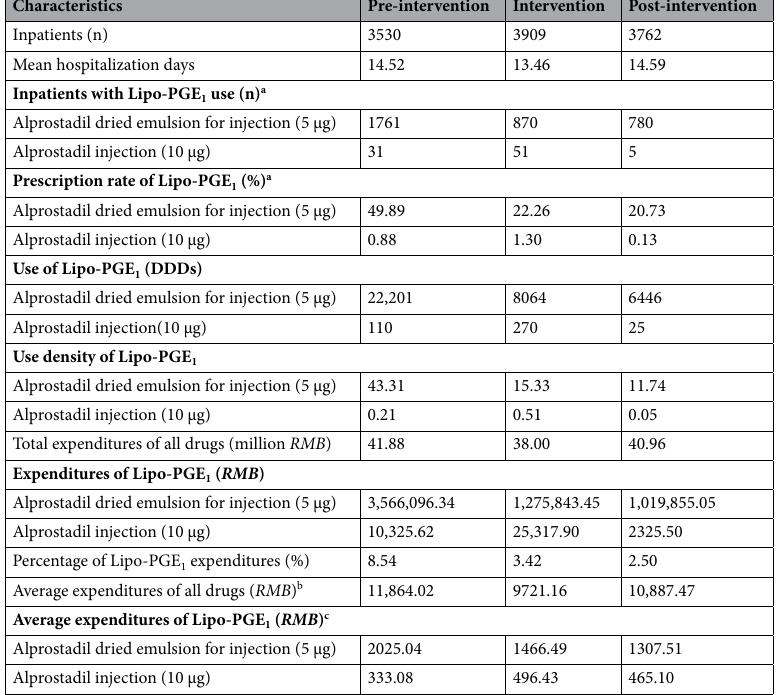
Characteristics of neurosurgical patients treated with Lipo‑PGE in pre‑, during, and post‑inter‑ 1 vention groups. A total of 1764, 879, and 785 neurosurgical patients were treated with Lipo-PGE 1 in pre-, during, and post-intervention groups, respectively. As shown in Table 3, the majority of patients were men, and most were 46–65 years of age or older. Alprostadil was wildly used in neurosurgery and was used for more than 20 kinds of clinical diseases in total. Before the intervention of Lipo-PGE 1 use, the top three ranked diseases were cerebral hemorrhage (28.40%), intracranial space-occupying lesions (11.28%), and cerebral contusion (11.05%); during the intervention, the top three listed diseases were cerebral hemorrhage (28.64%), intracranial injury (12.05%), and cerebral infarction (8.86%); after the intervention, the top three ranked diseases were cerebral infarction (33.76%), cerebral hemorrhage (16.43%), and fracture (7.90%). General characteristics of patients and expenditure of Lipo‑PGE in pre‑, during, and 1 post‑intervention periods. In the beginning, a total of 900 patients were enrolled in this study. Patients were randomly divided into three groups with 300 patients per group. Then, we excluded 99 patients who did not meet our inclusion criteria. At last, 801 patients in total were included for further research with 268 in the pre- intervention group, 263 in the intervention group, and 270 in the post-intervention group (Fig. 1). The general characteristics of the patients in three groups were listed in Table 4. The three groups were similar in demograph- ics and clinical characteristics, such as sex, age, and operation. There was no change in the price of Lipo-PGE 1 , other drugs, and hospital service during the study period. There were no significant differences in mean overall hospitalization costs and mean hospitalization days among three groups ( P > 0.05). However, significant reduc- tions in mean Lipo-PGE Frequency of Lipo‑PGE usage. During the study period, some patients may take two types of Lipo- 1 PGE 1 due to the drug shortage, which caused the frequency of Lipo-PGE 1 usage to be higher than the number of patients. As shown in Table 5, the frequency of Lipo-PGE 1 usage was 273 in the pre-intervention group and 280